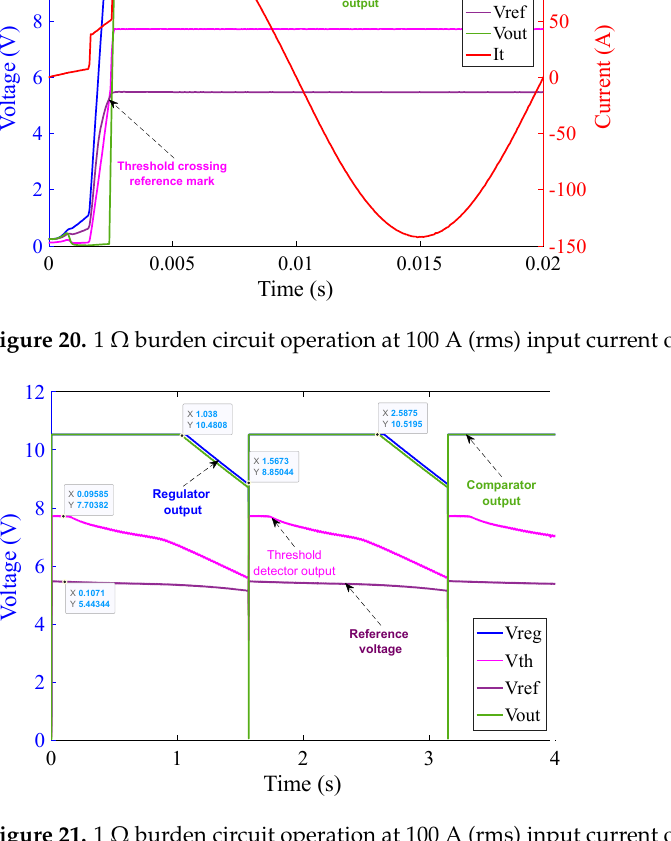
Figure 21. 1 Ω burden circuit operation at 100 A (rms) input current over the duration of 4 s.